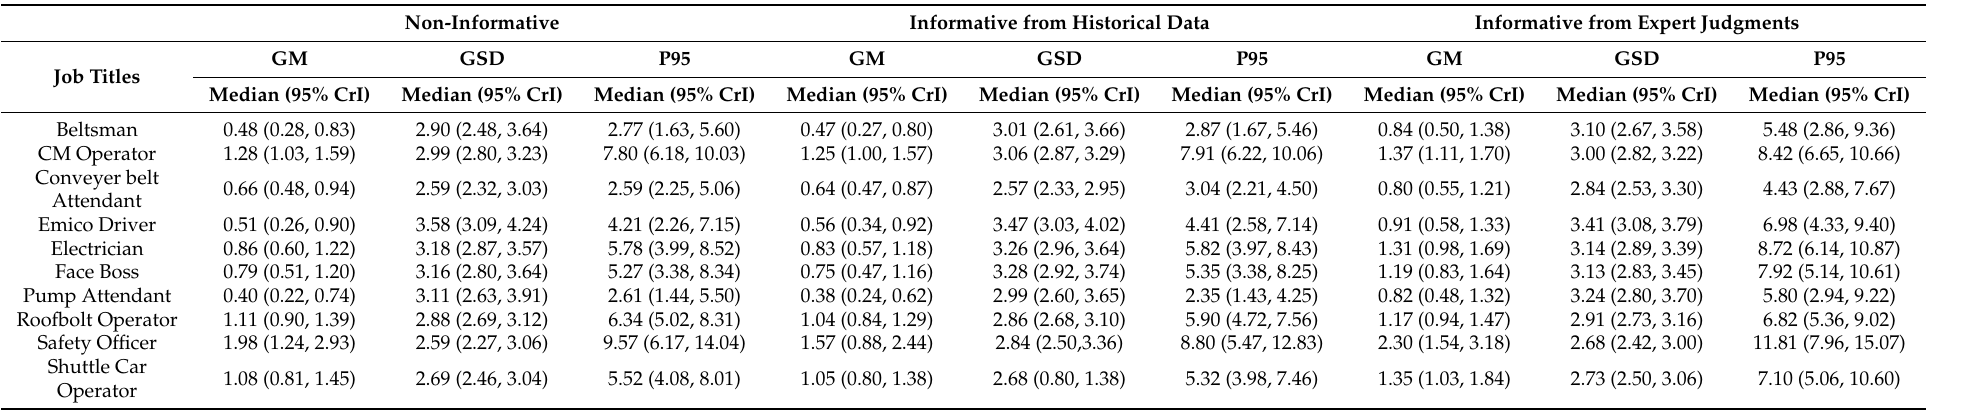
Table 2. The median (95% credible interval (CrI)) of the posterior GM, GSD, and the P95 percentiles of the TWA8hdust concentration and the P90 according DMRE CoP (OEL is 2 mg/m 3 ).